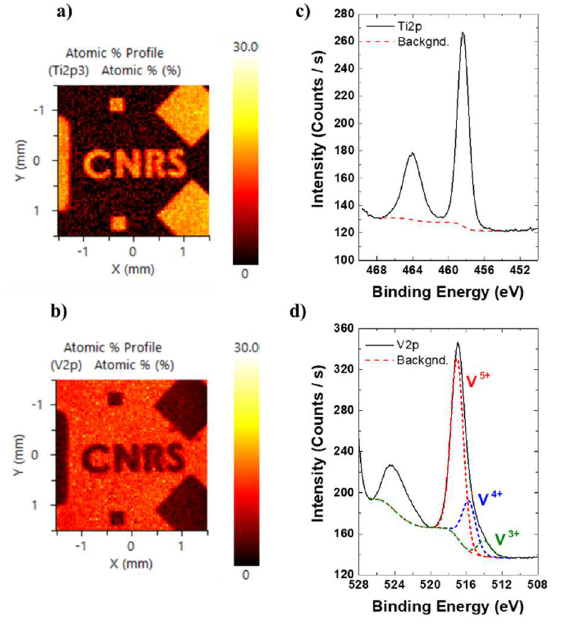
Fig. 2. Quantitative XPS maps (3 mm x 3 mm) of the STO/SVO stack for Ti2p (a) and V2p (b) elements and their corresponding integrated spectrum (c and d). V2p 3/2 peak is reconstructed to evidence vanadium oxidation states.